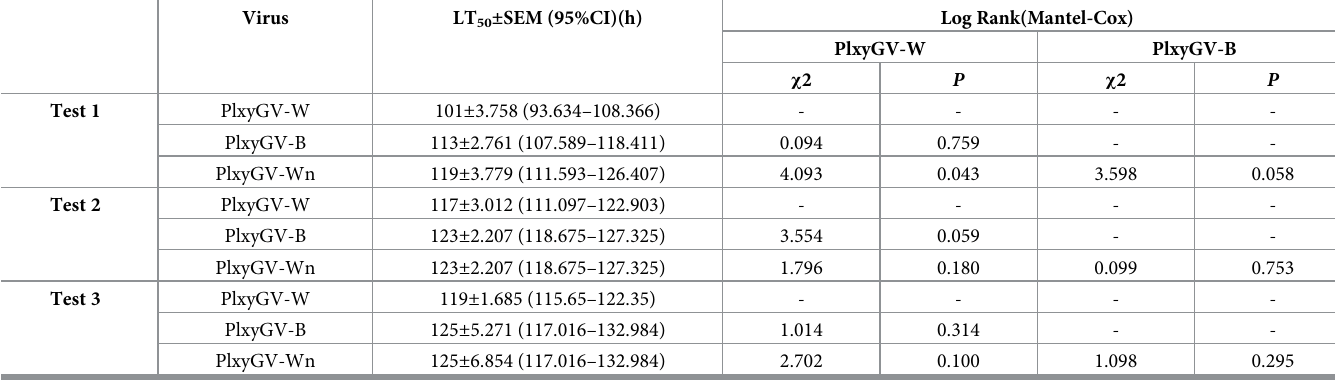
Table 4. Time-mortality of PlxyGV-W, PlxyGV-B and PlxyGV-Wn for Plutella xylostella larve.